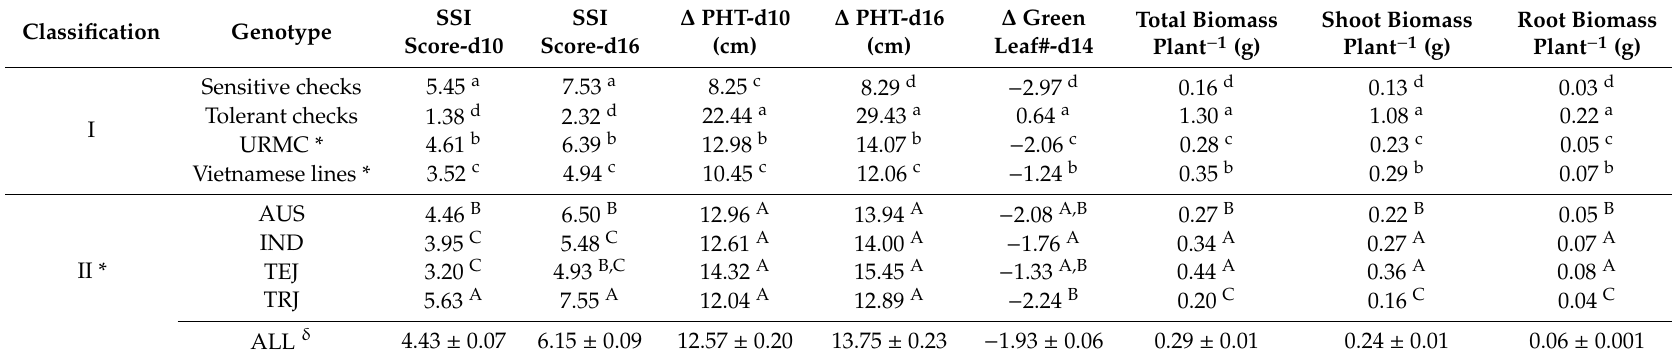
Table 1. Comparison of United States Department of Agriculture (USDA) rice mini-core and its four subpopulations, breeding lines from Vietnam, and salt tolerant and sensitive controls for seedling salt stress: ( a ) Least Squares Mean (LSMean) values and Tukey’s HSD analysis; ( b ) Range [minimum (Min) – maximum